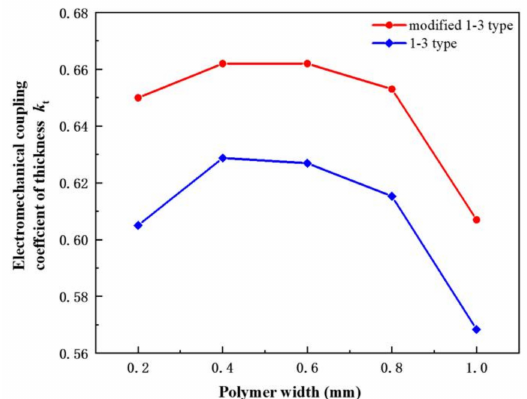
Figure 9. Comparison curve of electromechanical coupling coefficient of thickness with different polymer width.